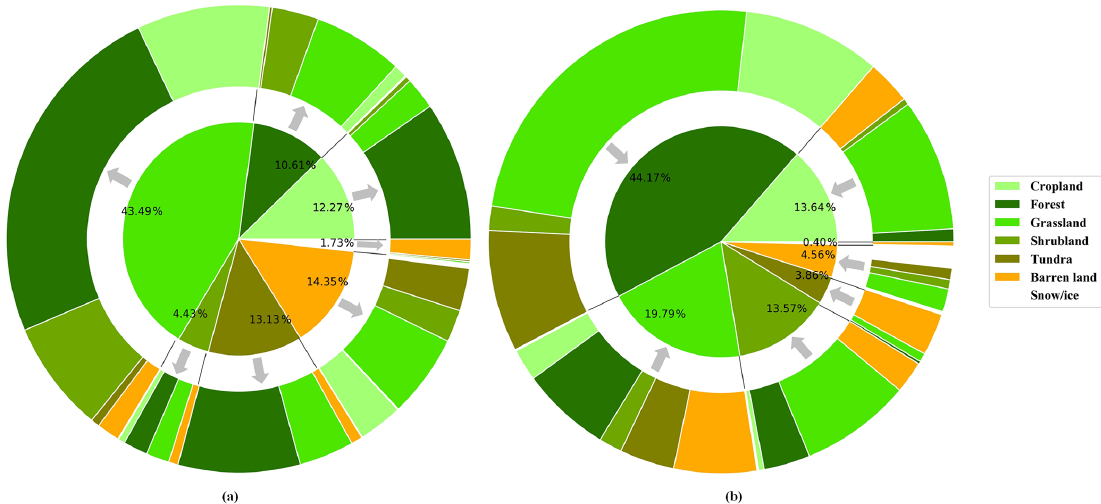
Figure 12. Land cover conversions with significant land cover change (LCC) between 1982 and 2015. The inner pie in (a) shows the percentages of different gross gain for each land cover, and the outer ring indicates which land cover the gross gain came from. The inner pie in (b) shows the percentage of different gross loss for each land cover, and the outer ring indicates which land cover the gross loss went to.